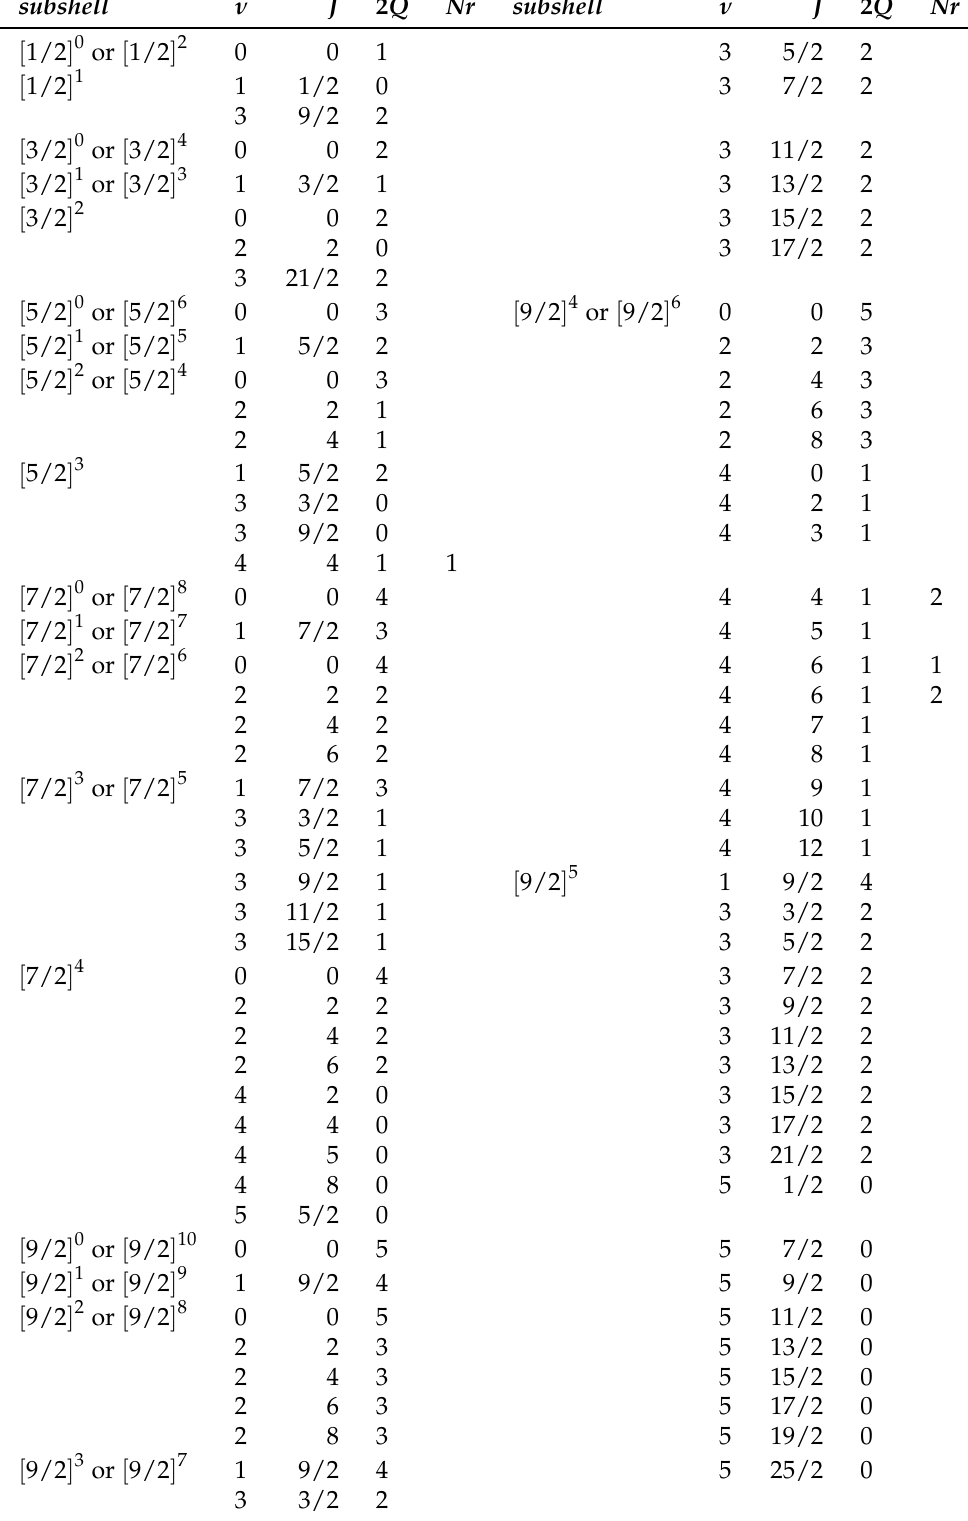
Table 2. Subshell states [ j ] w are listed for j = 1/2, . . . , 9/2, in both seniority ( ν ) and quasi-spin ( 2 Q ) representations. An extra number Nr is introduced for j =